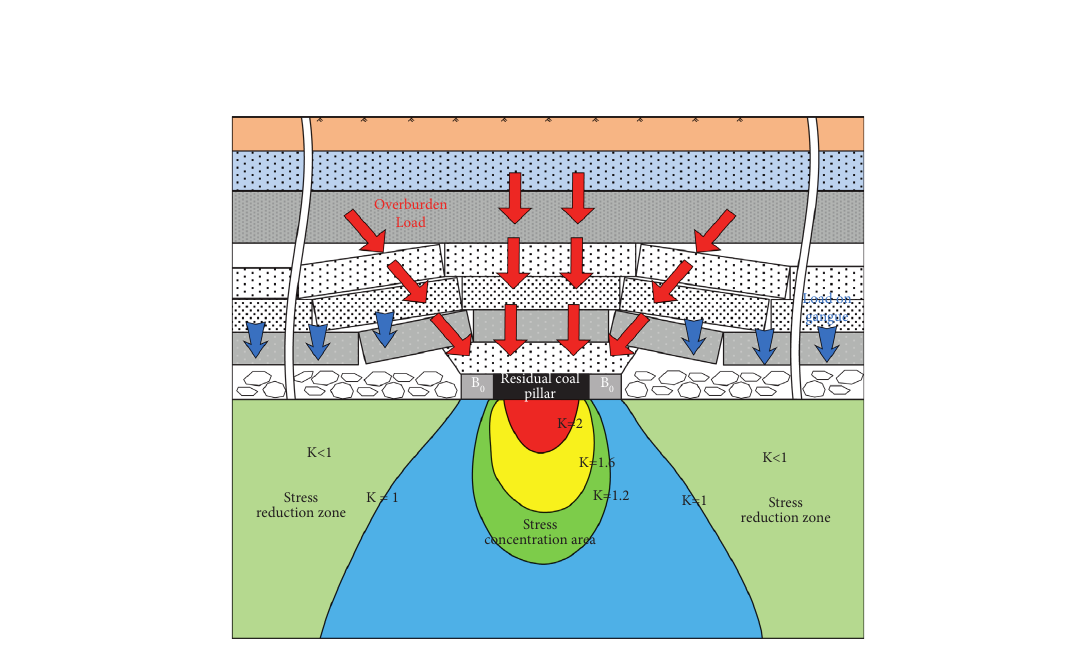
Figure 9: Transmission and distribution of the overlying load.